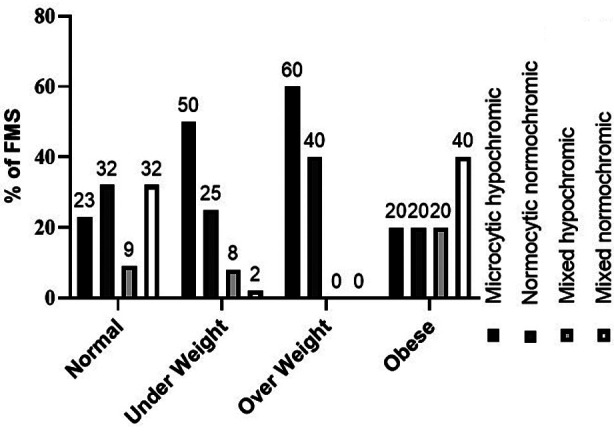
Distribution of morphological types of anaemia by BMI categories of Female Medical Students n 49.